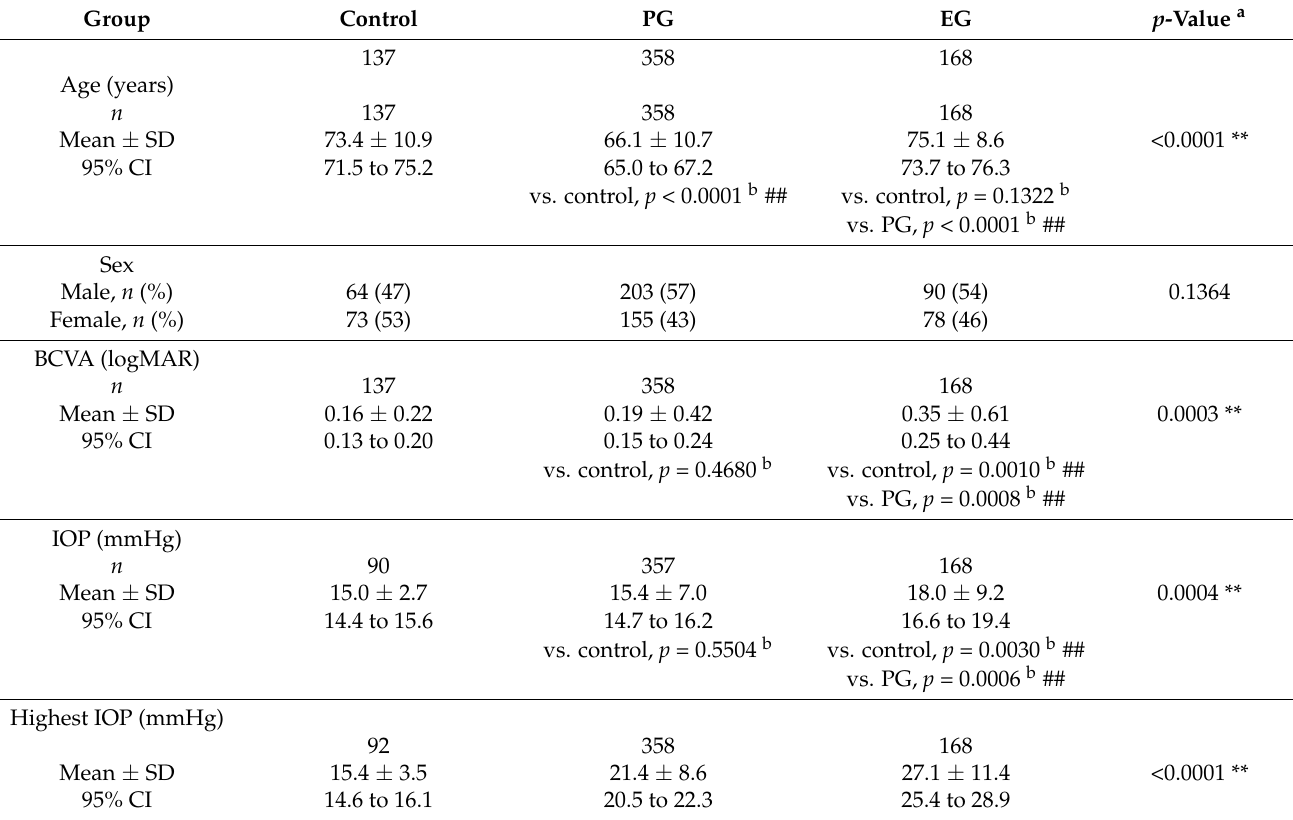
Table 1. Demographic subject